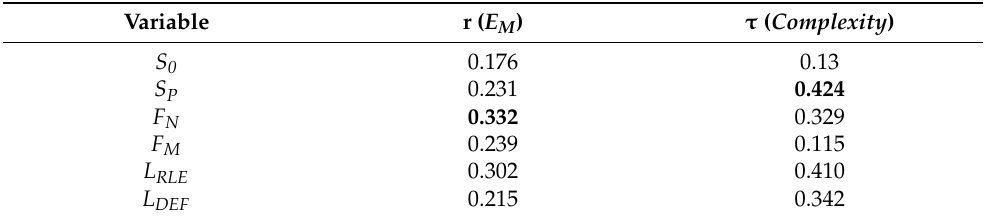
Table 2. Correlations of the independent variables with E M (Pearson) and Complexity (Kendall tau-b).